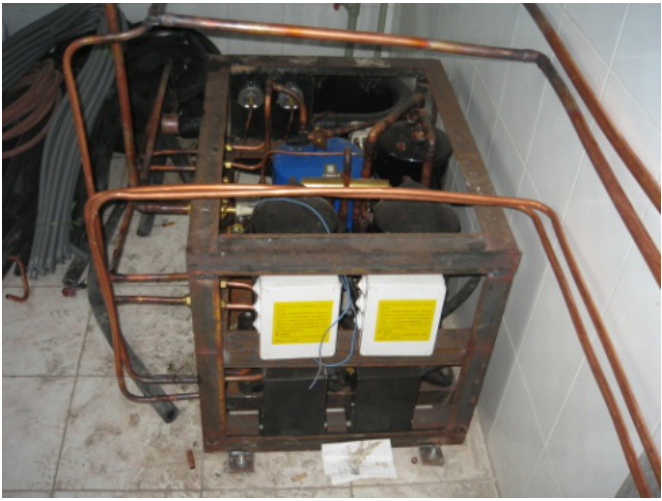
Figure 8. The picture of the real system.